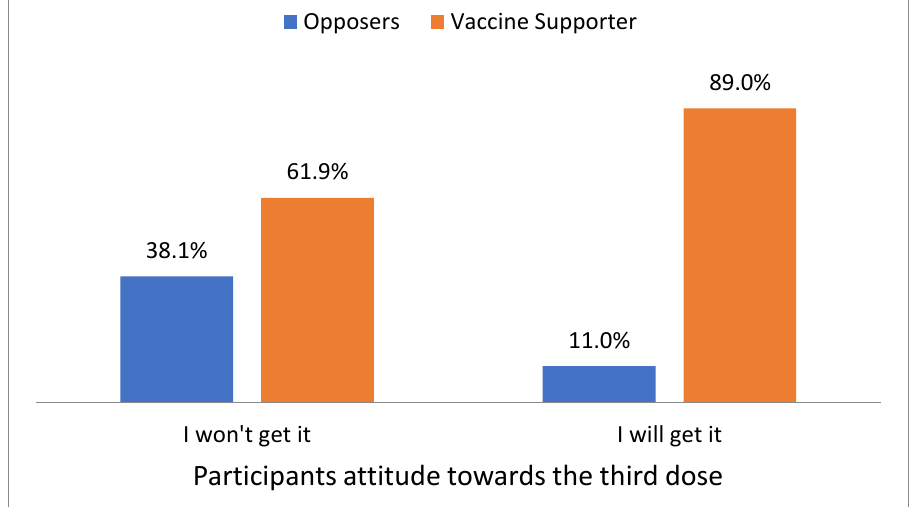
Figure 2. Participants ’ attitudes towards the third dose.